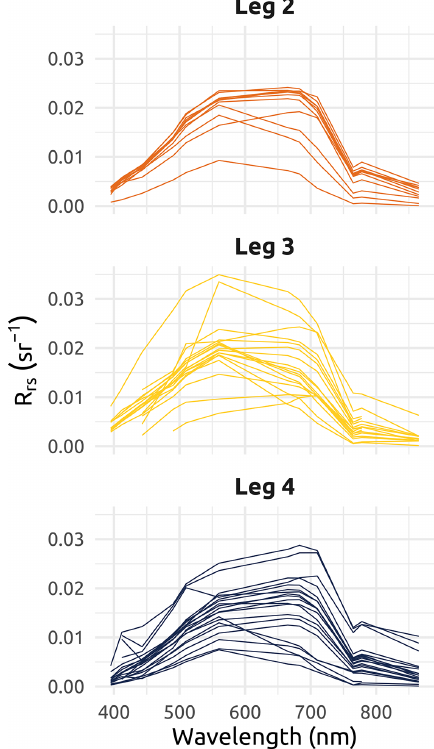
Figure 8. Remote sensing reflectance ( R rs ; per steradian) spectra measured using the C-OPS between 395 and 865nm during Legs 2, 3, and 4. Note that R rs spectra were not measured during Leg